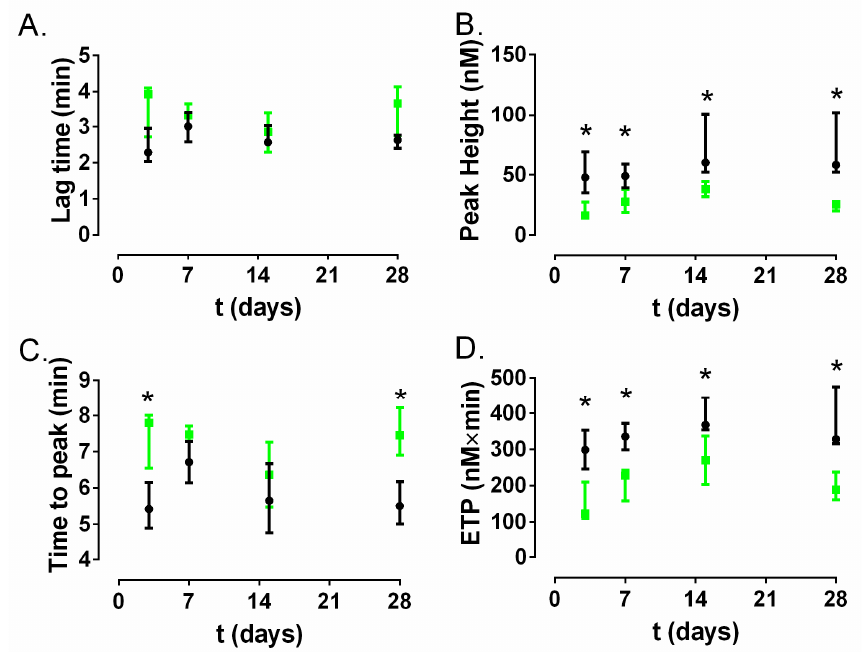
Figure 7. Coagulation model results obtained with ST Genesia ® for the control catheter group (black) and the A50-coated catheter group (green) over time: time to start thrombin generation (lag time) ( A ); time to reach the maximum peak of thrombin (time to peak) ( B ); the maximum peak of thrombin formation (peak height) ( C ) and the total amount of thrombin generated (endogenous thrombin potential, ETP) ( D ). *: p -value < 0.05 for Wilcoxon test between the control catheter group and A50-coated catheter group.